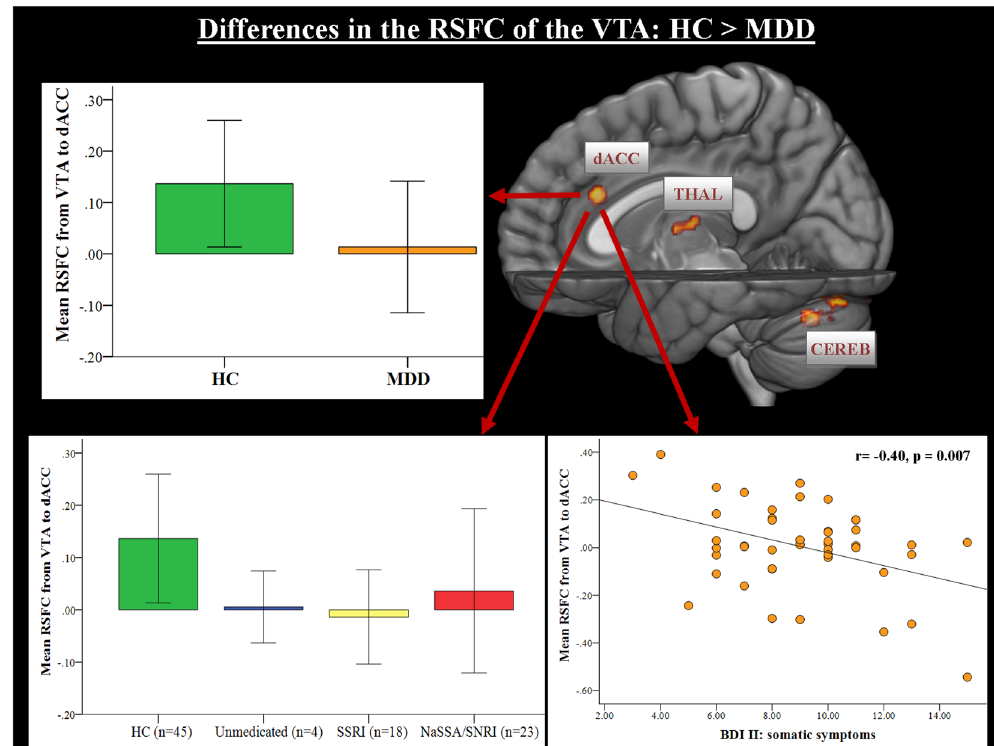
Figure 1. Whole-brain resting-state functional connectivity maps with seed region in the ventral tegmental area (VTA). In the upper part of the figure, the comparison between healthy controls vs. depressed patients demonstrated that patients had weaker functional connectivity from VTA to dACC, mediodorsal thalamus and bilateral cerebellum. The average BOLD time course of the voxels within the VTA was extracted for the FC analysis from the unsmoothed midbrain/brainstem functional data, which were normalized using the SUIT toolbox and DARTEL approach. In the lower left part of the figure, functional connectivity from VTA to dACC is shown split according to the class antidepressant treatment. The error bars in the graphs of the RSFC from VTA to dACC represent standard deviation. In the lower right part of the figure, a significant correlation between the functional connectivity from the VTA to dACC and BDI-II somatic symptoms in patients with MDD is depicted. The somatic factor as computed according to Vanheule, et al . 22 is composed of BDI-II items such as fatigue, appetite disturbance, loss of sexual interest and concentration difficulties. Abbr.: dACC, dorsal anterior cingulate cortex; PCC, posterior cingulate cortex; THAL, thalamus; CEREB, cerebellum; SSRI, selective serotonin reuptake inhibitors; SNRI, serotonin and noradrenalin reuptake inhibitors; NaSSA, noradrenergic and specific serotonergic